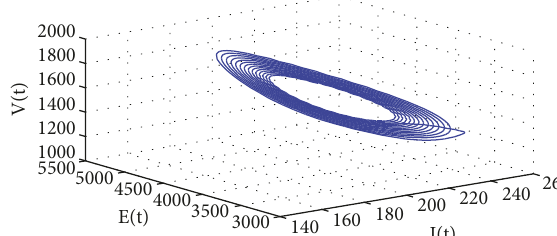
Figure 4: Dynamic behavior of system (35): projection on V-E-I with 𝜏 = 76.65 > 𝜏 0